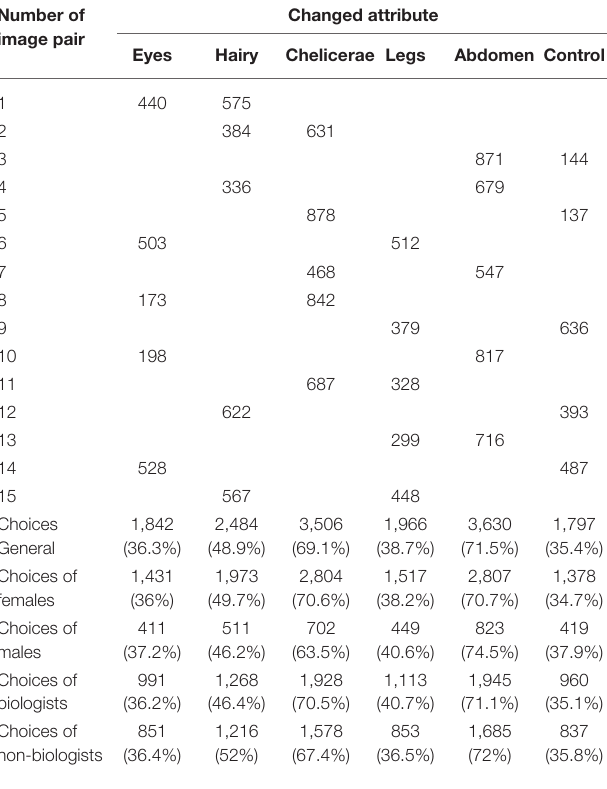
TABLE 5 | Number of choices for each pair for each image in disgust perception testing (general, gender, and biological education). Number of image